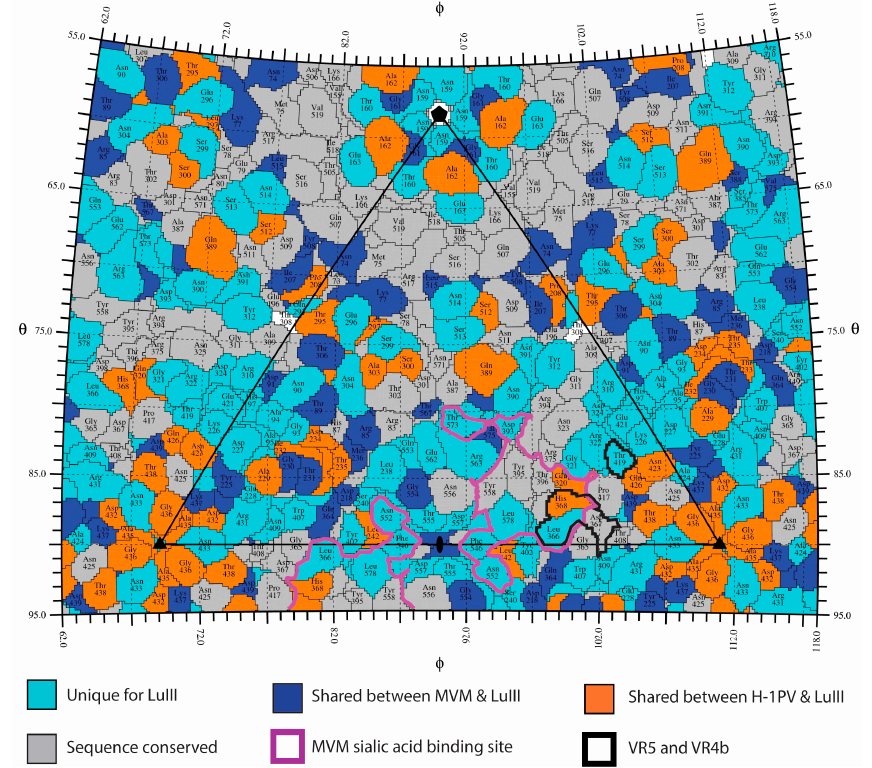
Figure 6. Distribution of amino acid sequence identity for the rodent protoparvoviruses. 2D projection roadmap of the LuIII capsid surface showing the viral asymmetric unit (black triangle). Colors are as indicated.VP2 positions containing an amino acid that is unique to LuIII are in cyan. Residues identical between: MVM and LuIII (blue), H-1PV and LuIII (orange), or conserved among all three viruses (gray). The remaining residues in white are identical between H-1PV and MVM only. The sialic acid binding site identified for MVM and predicted for H-1PV is delineated in purple (see bold outline). Important surface exposed residues within VR5 and VR4b are delineated in black. Icosahedral axes are indicated by the filled oval (2-fold), triangle (3-fold), and pentagon (5-fold).